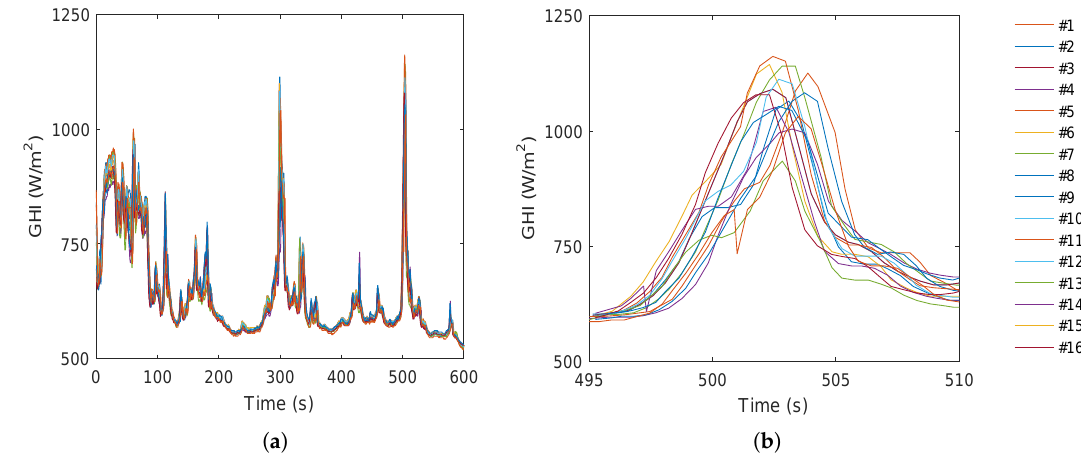
Figure 7. Estimated irradiance from the 16 motes: 10-min period ( a ); and 15-s detail ( b